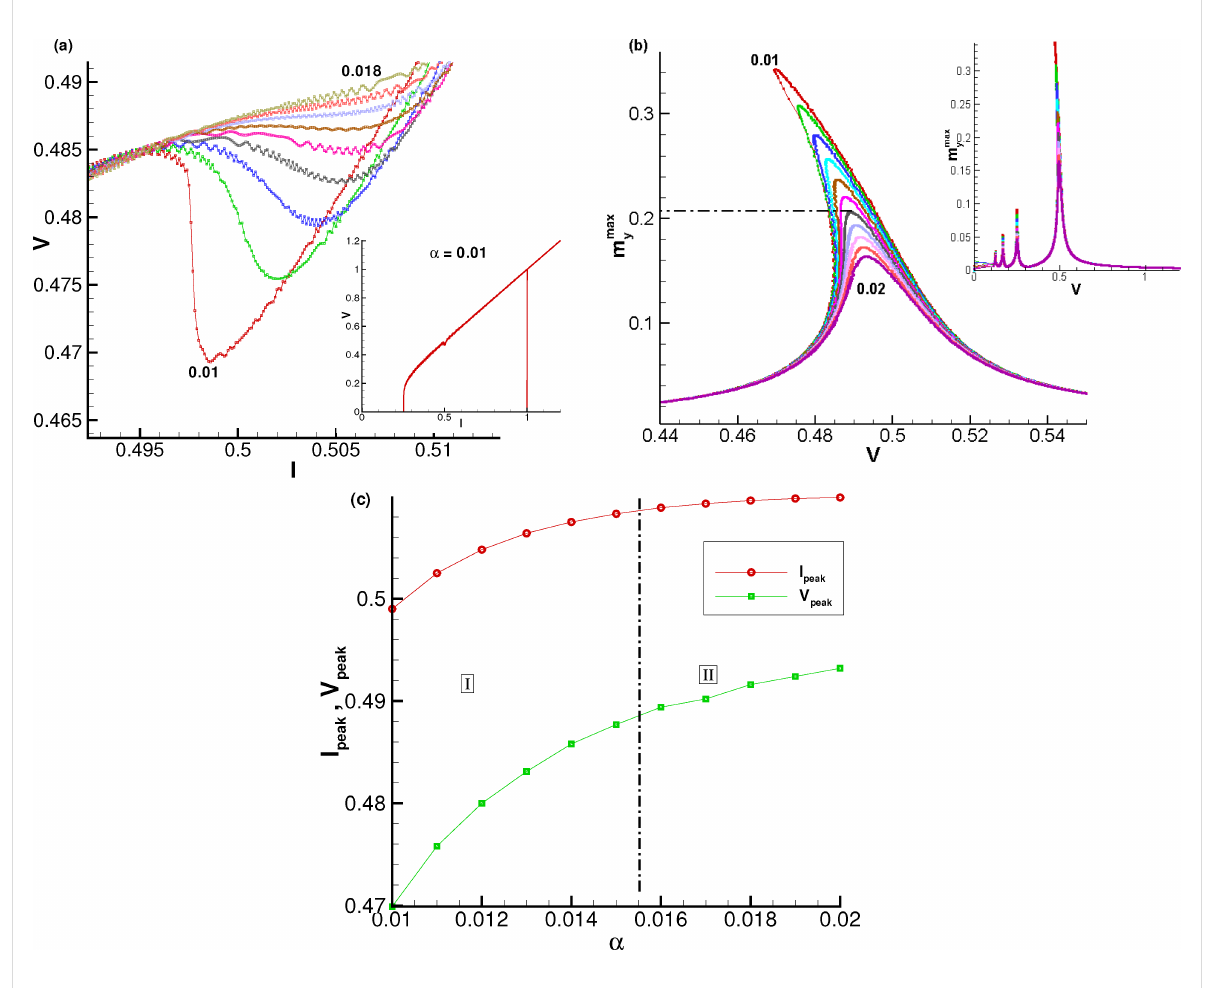
Figure 7: (a) Enlarged parts of the I – V curves at different values of α . (b) Voltage dependence of at different α . (c) α -Dependence of the resonance curve maximum in current ( I peak ) and voltage ( V peak ). The numbers indicate the value of α from 0.01 to 0.018 in (a) and from 0.01 to 0.02 in (b) by an increment 0.001. Results were obtained at r = 0.13 and G =